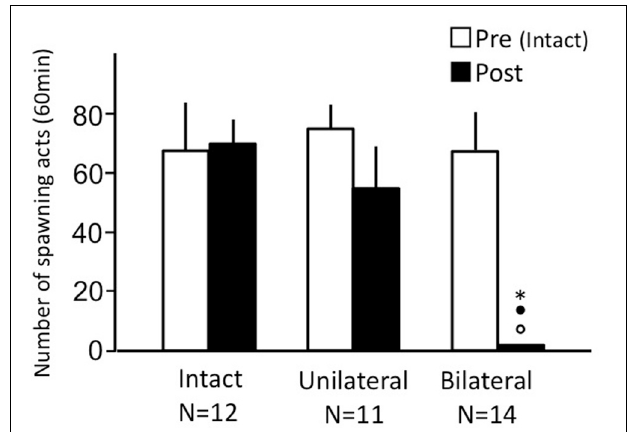
FIGURE 1 | Effects of nasal occlusion on male sexual behavior in male goldfish. Pre, Pre-treatment (open column). Post, post-treatment (solid column). Each column represents the mean and s.e.m. Difference compared to pre-treatment (asterisk), compared to intact fish (solid circle), and compared to unilaterally occluded fish (open circle). Level of significance, p < 0 . 05.